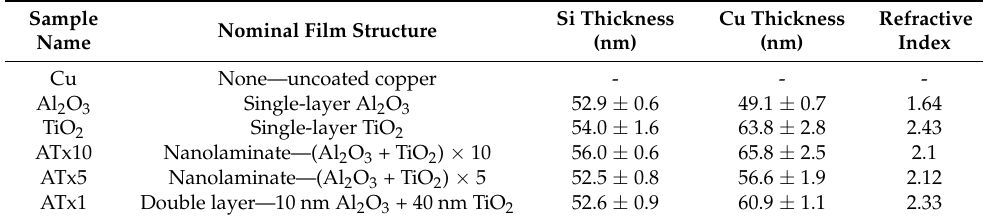
Table 1. Samples tested in this work—naming convention, film type, and ellipsometric data. The Si Thickness and Cu Thickness columns indicate fitted film thicknesses on the respective substrates using spectroscopic ellipsometry. Refractive indices are determined from film measurements on silicon substrates.